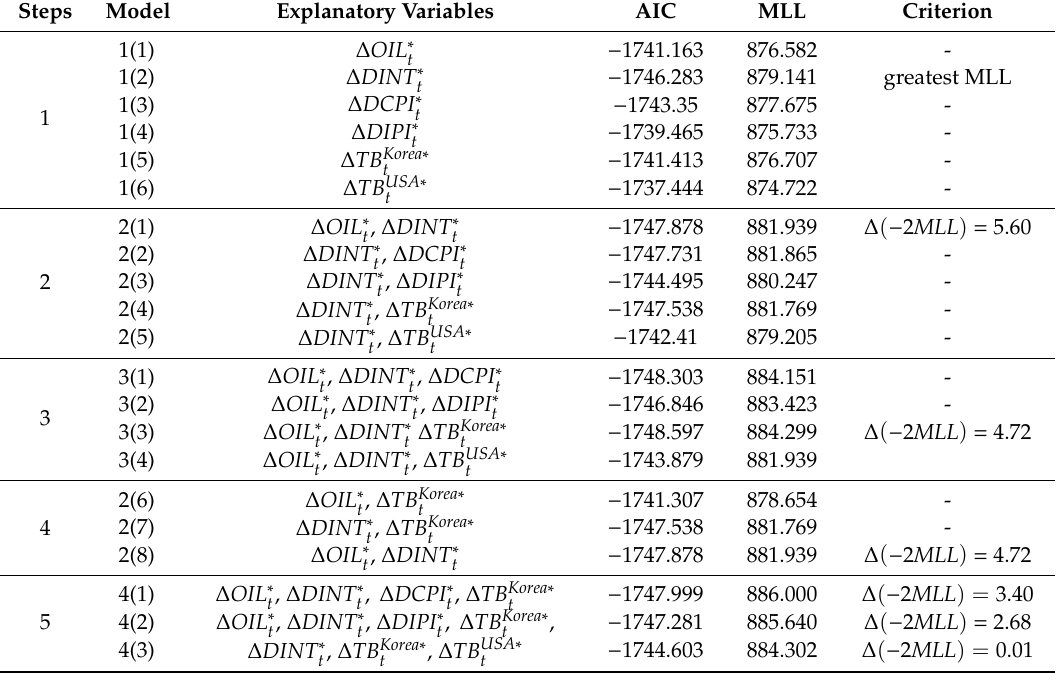
Table 1. Model Selection Process with Method 1 in